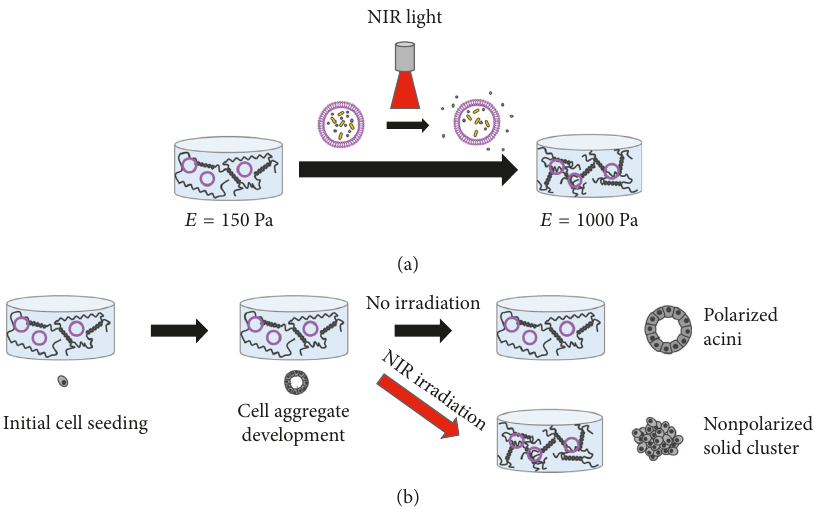
Figure 2: Epithelial cell transformation in dynamic culture system. (a) Alginate-Matrigel IPN loaded with liposomes containing calcium and AuNR. Calcium is released from the liposomes via AuNR SPR upon NIR irradiation, stiffening the bulk elastic modulus ( E ) from 150 to 1000Pa. (b) Mammary epithelial cells encapsulated within the soft gel for polarized cell aggregates (acini) over culture. However, stiffening of this gel disrupts acinar formation, leading to invasive